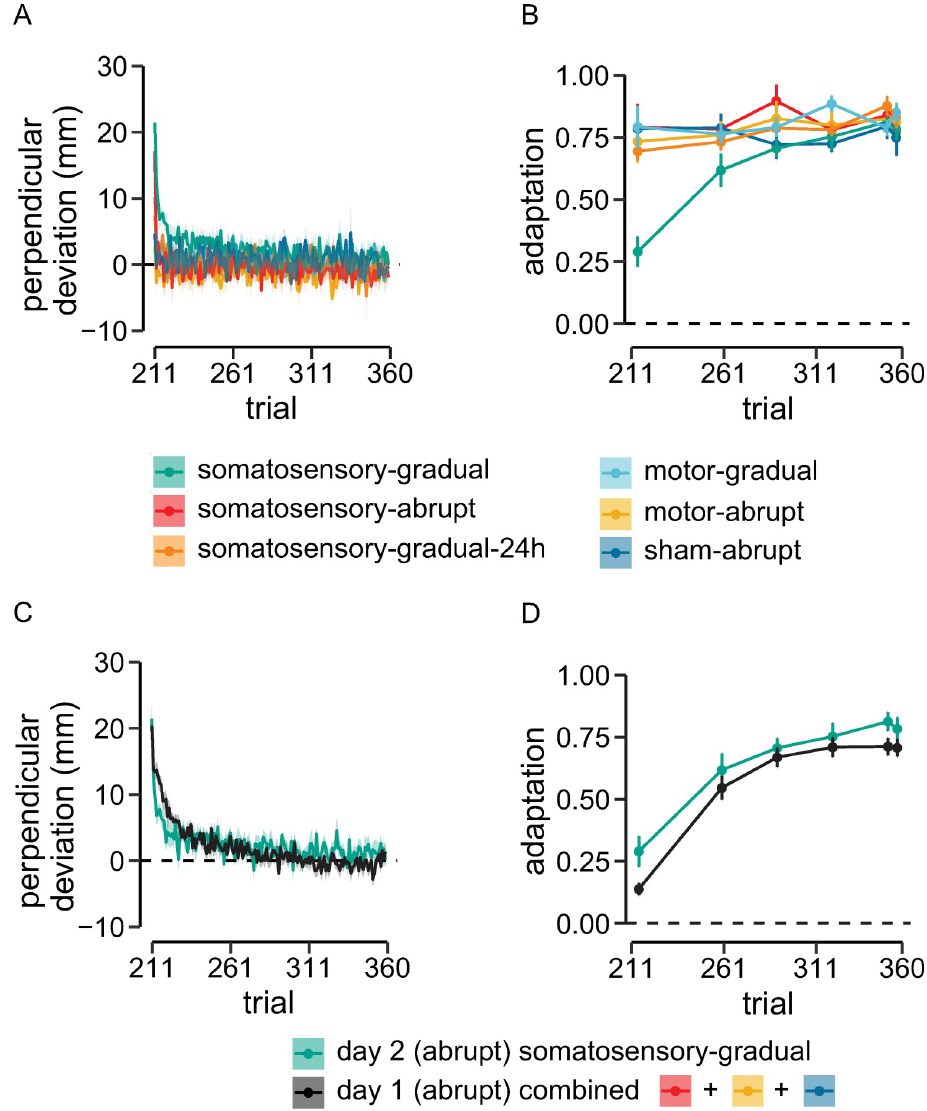
Fig 4. Suppression of somatosensory cortex causes participants to behave like na ï ve learners when reexposed to the perturbation. (A) There is rapid relearning in groups that had shown retention in the preceding error-clamp trials (motor-gradual, motor-abrupt, somatosensory-abrupt, somatosensory-gradual-24, sham-abrupt). Participants in somatosensory-gradual group showed slower relearning. (B) For participants shown in (A), from the beginning of the relearning session, adaptation coefficients are similar to those at the end of initial learning on day 1. (C) Relearning following cTBS for somatosensory-gradual group overlaid on averaged initial learning performance of na ï ve participants learning an abruptly introduced load. Note that all conditions shown here involved learning an abruptly introduced perturbation. (D) Overlay of adaptation coefficients during the relearning session for the somatosensory- gradual group with those of na ï ve participants. Performance of somatosensory-gradual group in the relearning session was similar to na ï ve learners, indicating the participation of somatosensory cortex in motor memory consolidation. Shaded regions and error bars give standard errors across participants. Data used to generate the figures in (A), (B), (C), and (D) can be found in S4 Data. cTBS, continuous theta-burst transcranial magnetic stimulation.